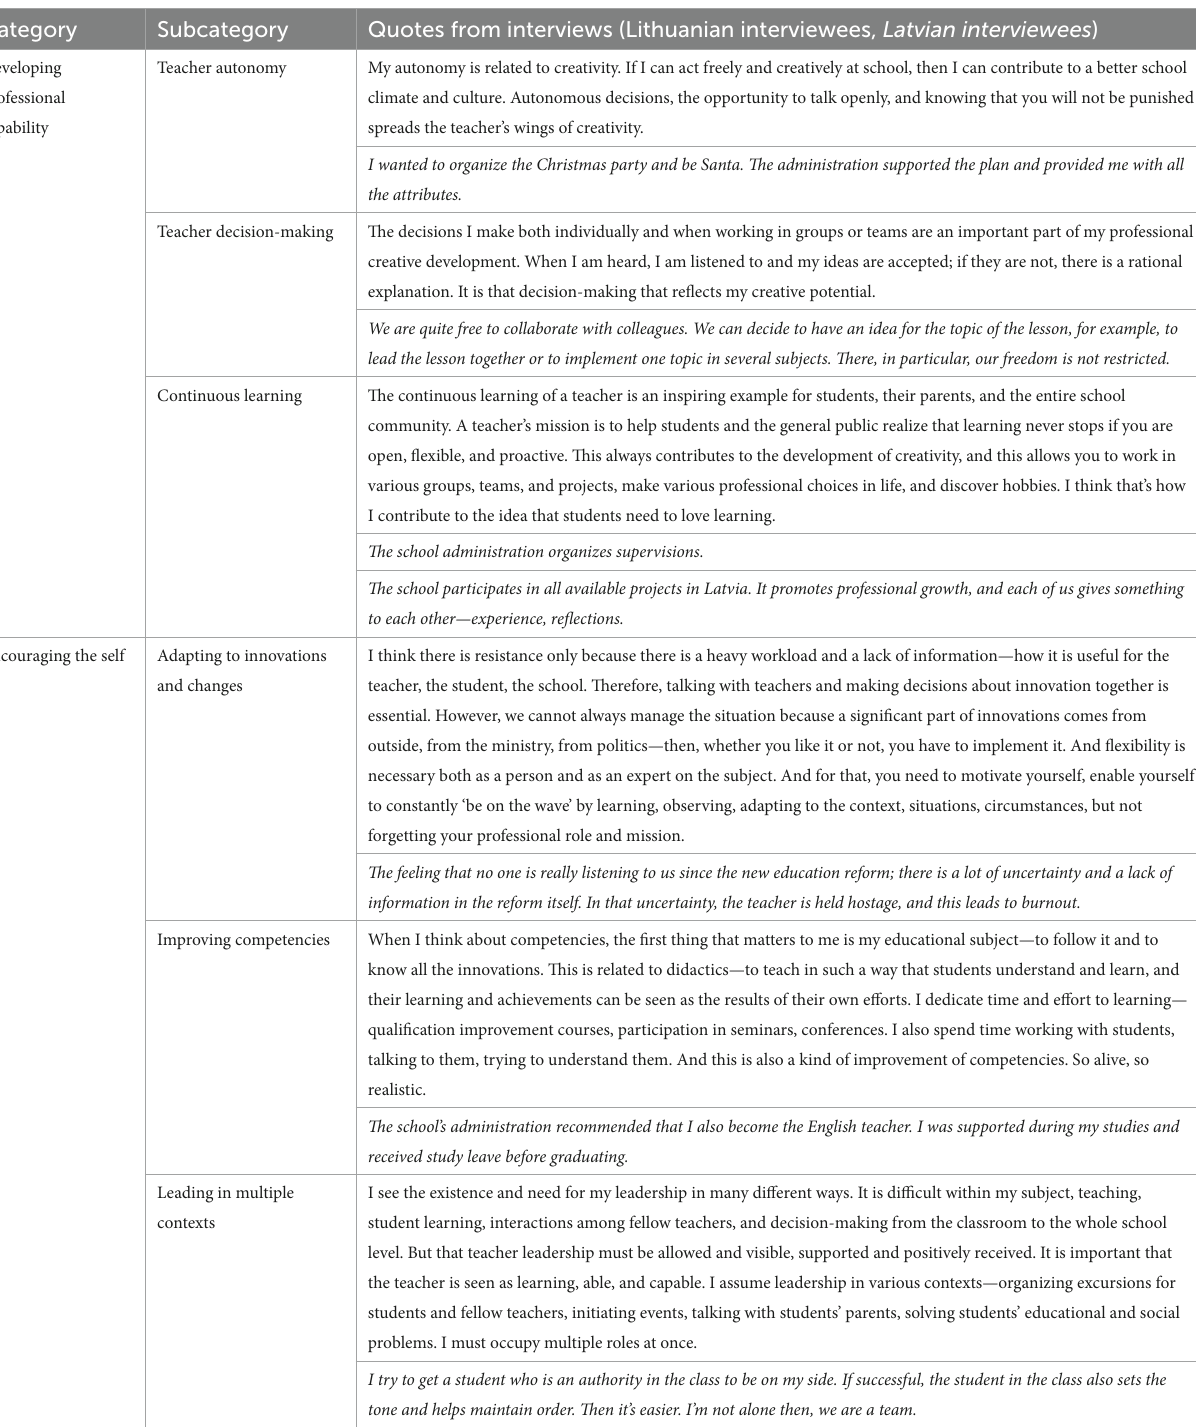
TABLE 1 Content of similar categories in Latvian ( n = 83) and Lithuanian ( n = 69) teachers’ answers to the question “How do you contribute to a positive school climate?”